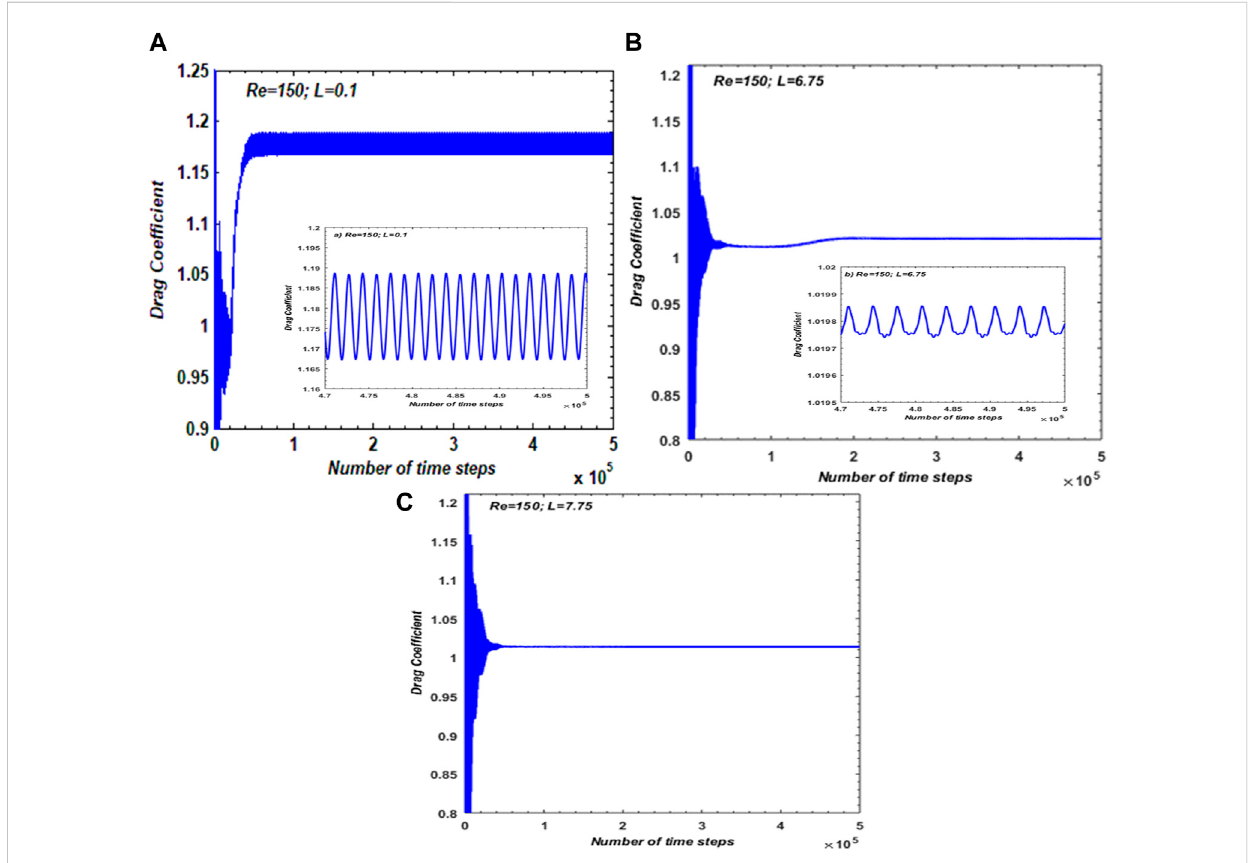
FIGURE 6 CD graphs corresponding to different fl ow modes: (A) Unsteady, (B) Tranisent, and (C) Steady fl ow